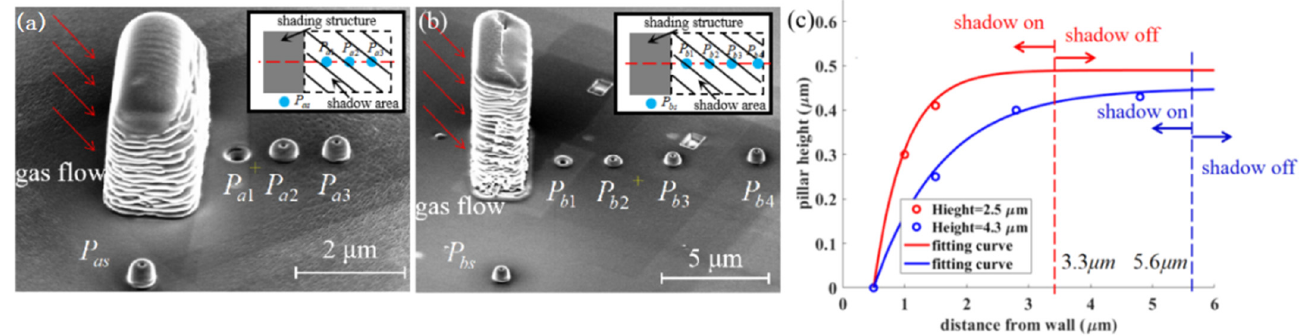
Figure 4. Pillars grown behind an ( a ) 1.8 µ m × 3.8 µ m × 2.5 µ m; ( b ) 1.8 µ m × 3.8 µ m × 4.2 µ m rectangular shading structure; ( c ) experimental results and fitting curve of the pillar heights. The nozzle is on the left of the figure.